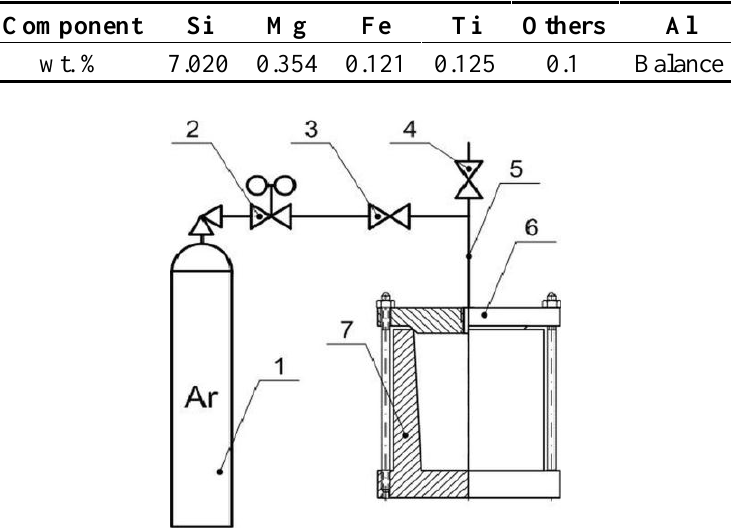
Figure 1. Gas-dynamic treatment (GDT) system used in the research. 1, inert gas (Ar) cylinder; 2, valve; 3, 4, non-return valve; 5, gas pipe; 6, solidifying container cover; 7, solidifying